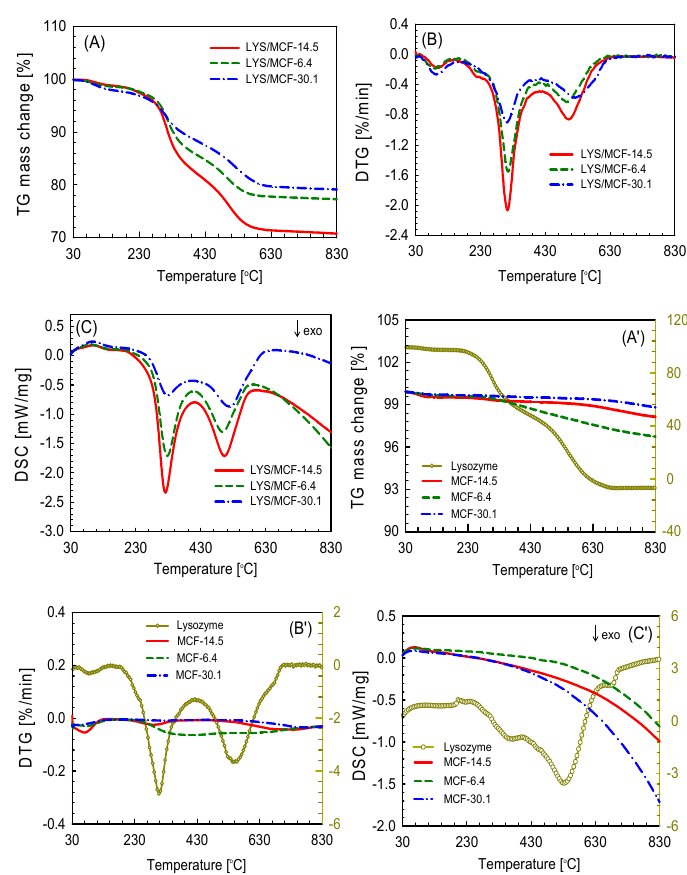
Figure 4. Thermogravimetric analyzer (TG) profiles in synthetic air for selected LYS/MCF composites ( A ), native protein and pure MCF supports ( A ’); DTG curves in synthetic air for selected LYS/MCF composites ( B ), native lysozyme and pure MCF supports ( B ’); DSC curves for biocomposites ( C ), pure lysozyme and MCF silica supports ( C ’). Table 6. DSC data obtained in synthetic air for MCF materials before and after lysozyme adsorption. Table 5. TG and DTG data obtained in air atmosphere for LYS/MCF composites.